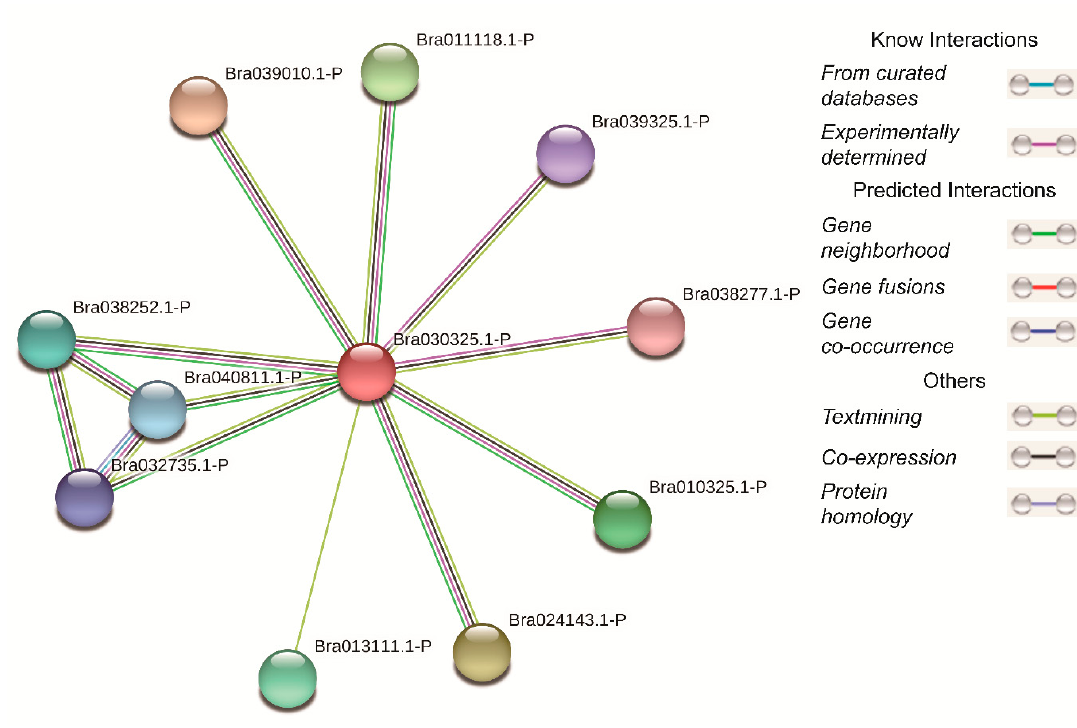
Figure 9. Online prediction of protein interactions.